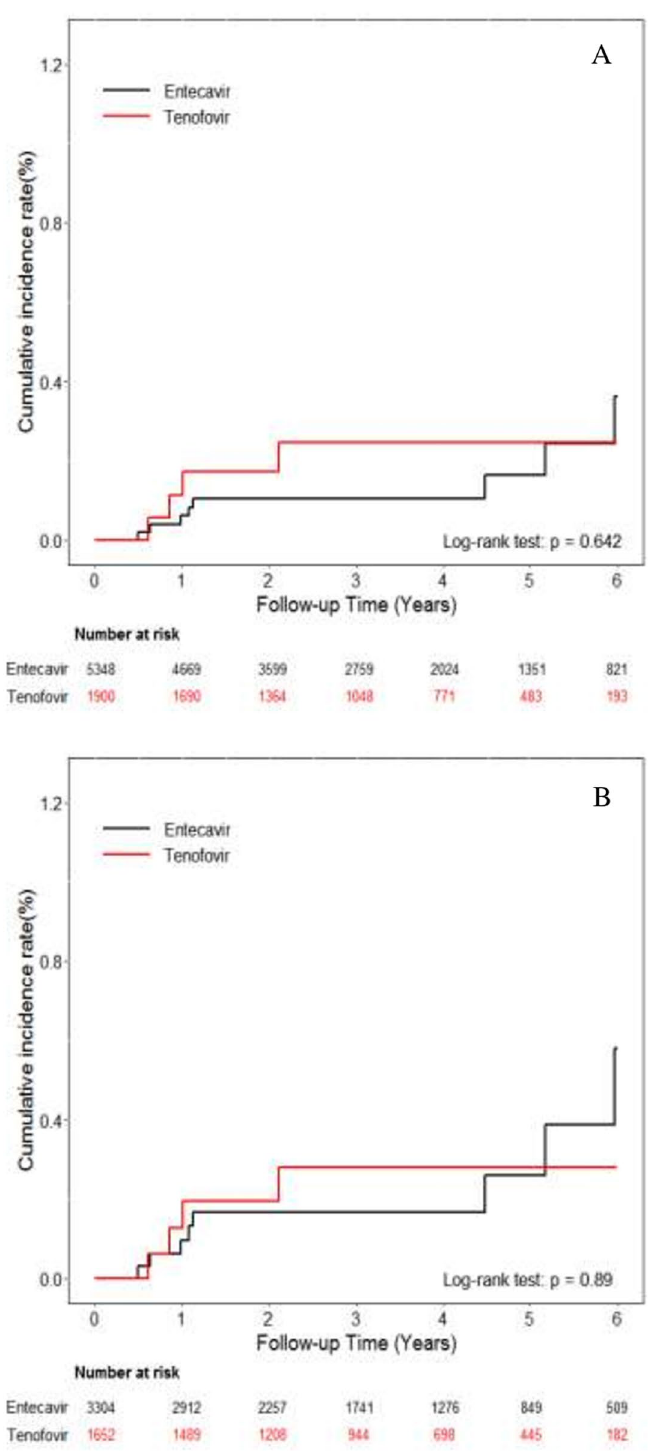
Figure 5. Cumulative incidences of ICC. ( A ) Entire cohort ( B ) Propensity score matching